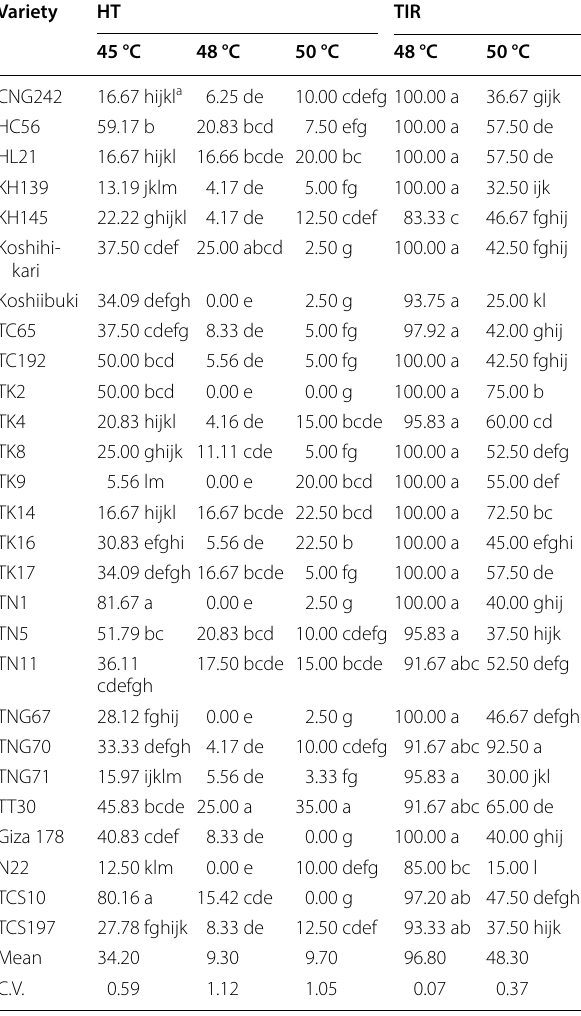
Table 3 Comparison of the seedling survival rates (%) of each rice variety under various high temperature treatments Variety